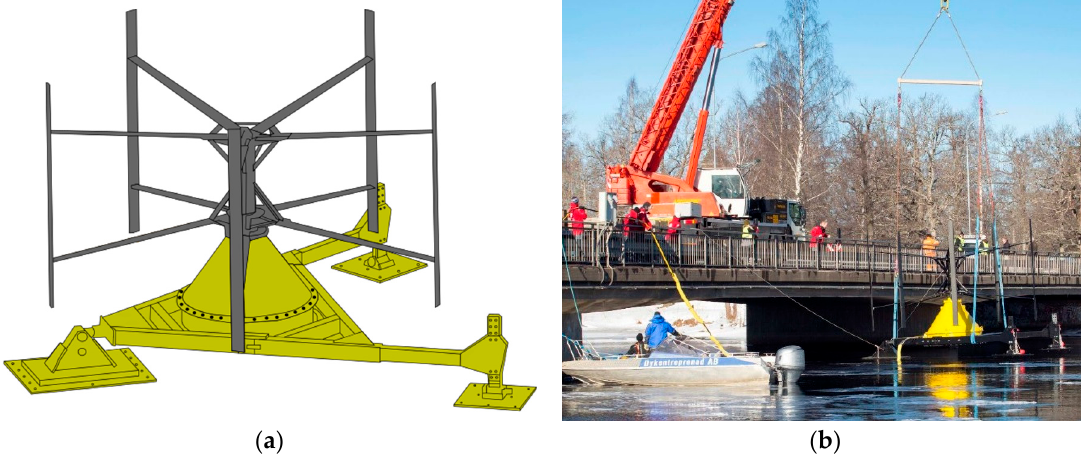
Figure 1. ( a ) The marine current energy converter developed at Uppsala University in Sweden; ( b ) Deployment of the device in Söderfors, Sweden, 7 March 2013 (Figure 4 in [15]). The large Uppsala MCC generator with many magnetic poles (here almost 2 m in diameter [17] and 112 poles [18]) generates power from lower water flow velocities than most TECs and